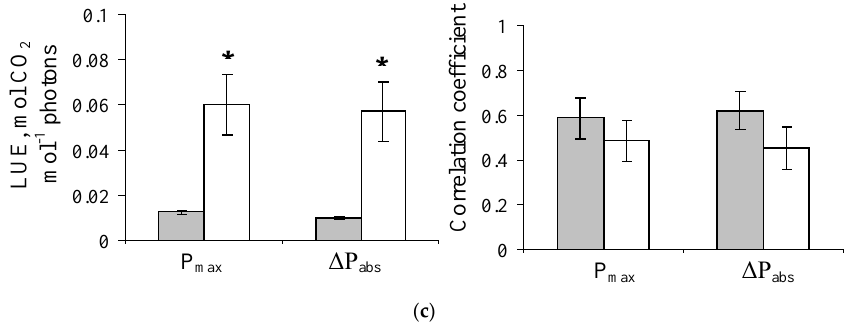
Figure 3. The influence of the distribution of ΔF/F m ’ ( a ); NPQ ( b ) and LUE ( c ) among investigated plants for the connection between these photosynthetic parameters with PRI at all variants of measurements. Average values of P min (P max ) and ΔP abs are shown on left panels, average correlation coefficients are shown on right panels. The label “low” indicates groups with low P min (P max ) and ΔP abs ; the label “high” indicates groups with high P min (P max ) and ΔP abs . “Low” groups had n = 55 (ΔF/F m ’), n = 25 (NPQ), and n = 31 (LUE); “high” groups had n = 55 (ΔF/F m ’), n = 25 (NPQ), and n = 32 (LUE). * the group significantly differed from another one ( p < 0.05, Student’s test).